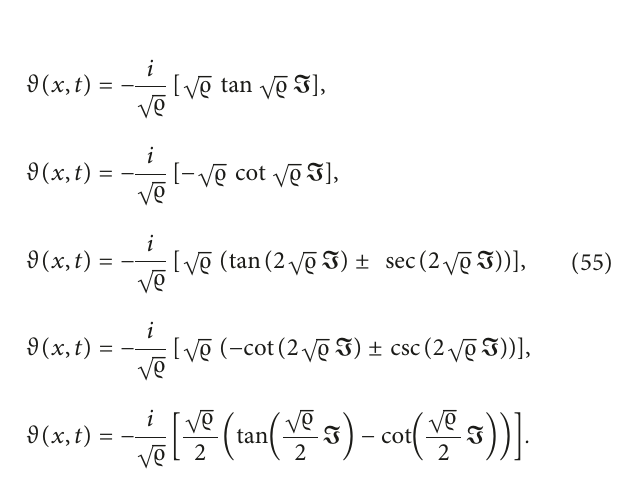
Figure 5: Solitary wave profile of ϑ